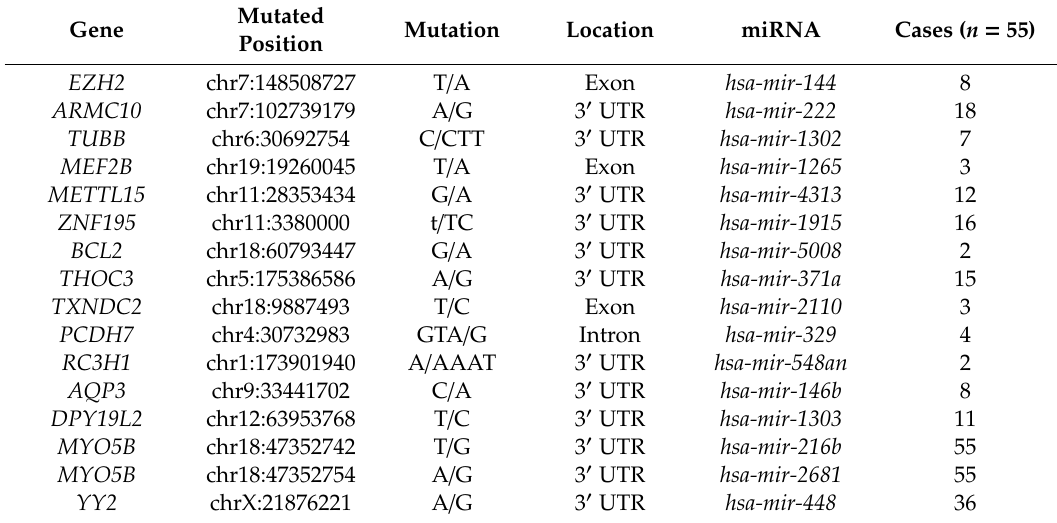
Table 1. Mutations from the original discovery cohort recurrently identified in the validation cohort.